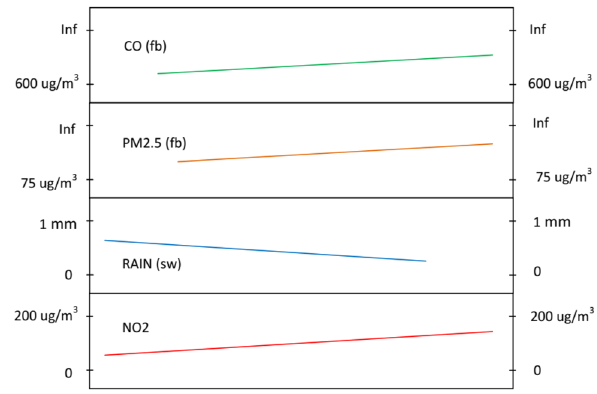
Fig. 3 The most frequent proto-pattern registered in Changping